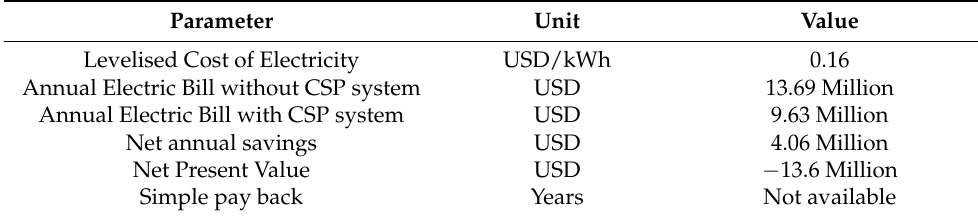
Table 17. Economic performance indicators for the CSP System.